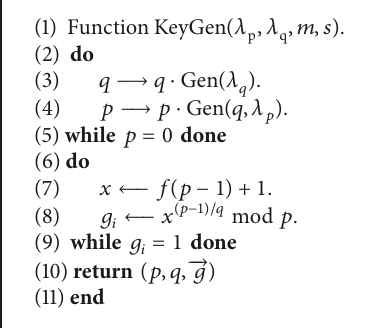
Algorithm 1: Initialization parameter generation algorithm.